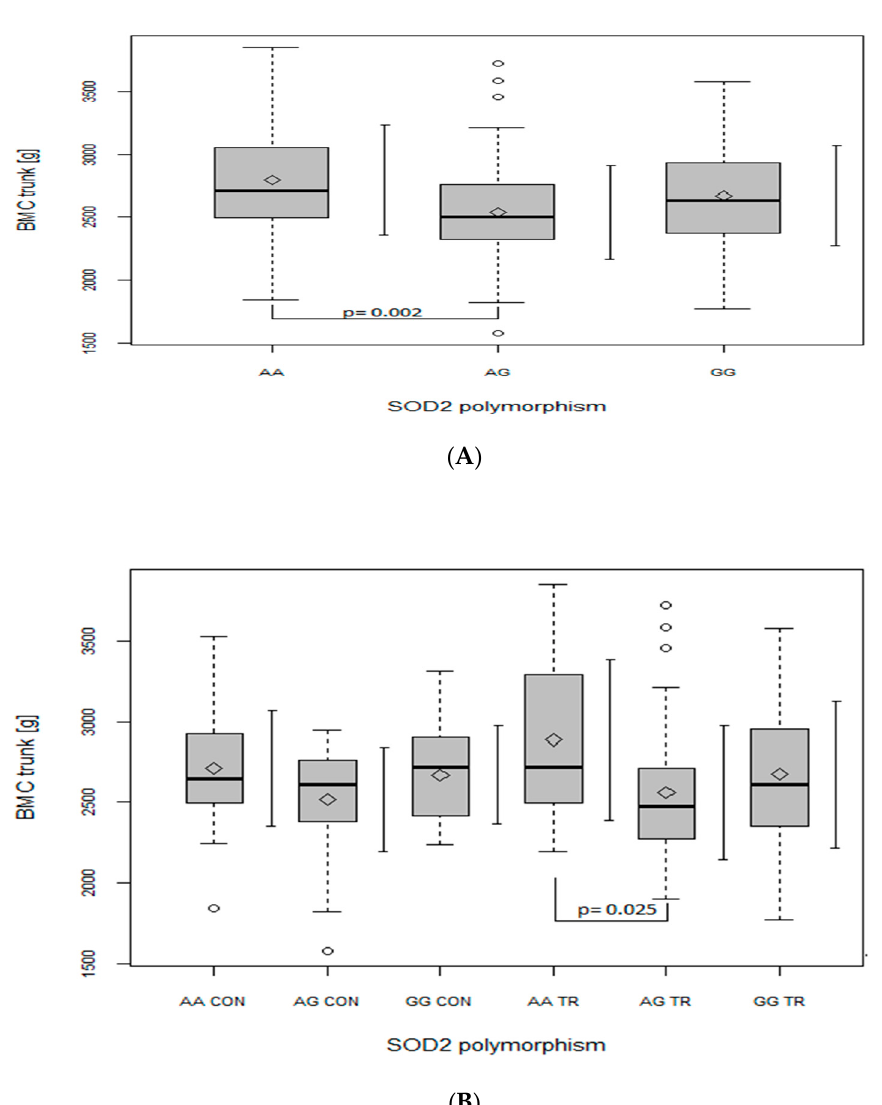
Figure 3. The effect of SOD2 polymorphism on bone mineral content (BMC) (g) of the trunk. ( A ) In the whole group; main effects: SOD2 ( p = 0.002; F = 6.24). ( B ) In control (CON) and trained (TR) group; main effects: SOD2 ( p = 0.002; F = 6.22). Key: ◊ —mean; ○ —outliers value; boxplots—median Q1–Q4 and mean ± SD.